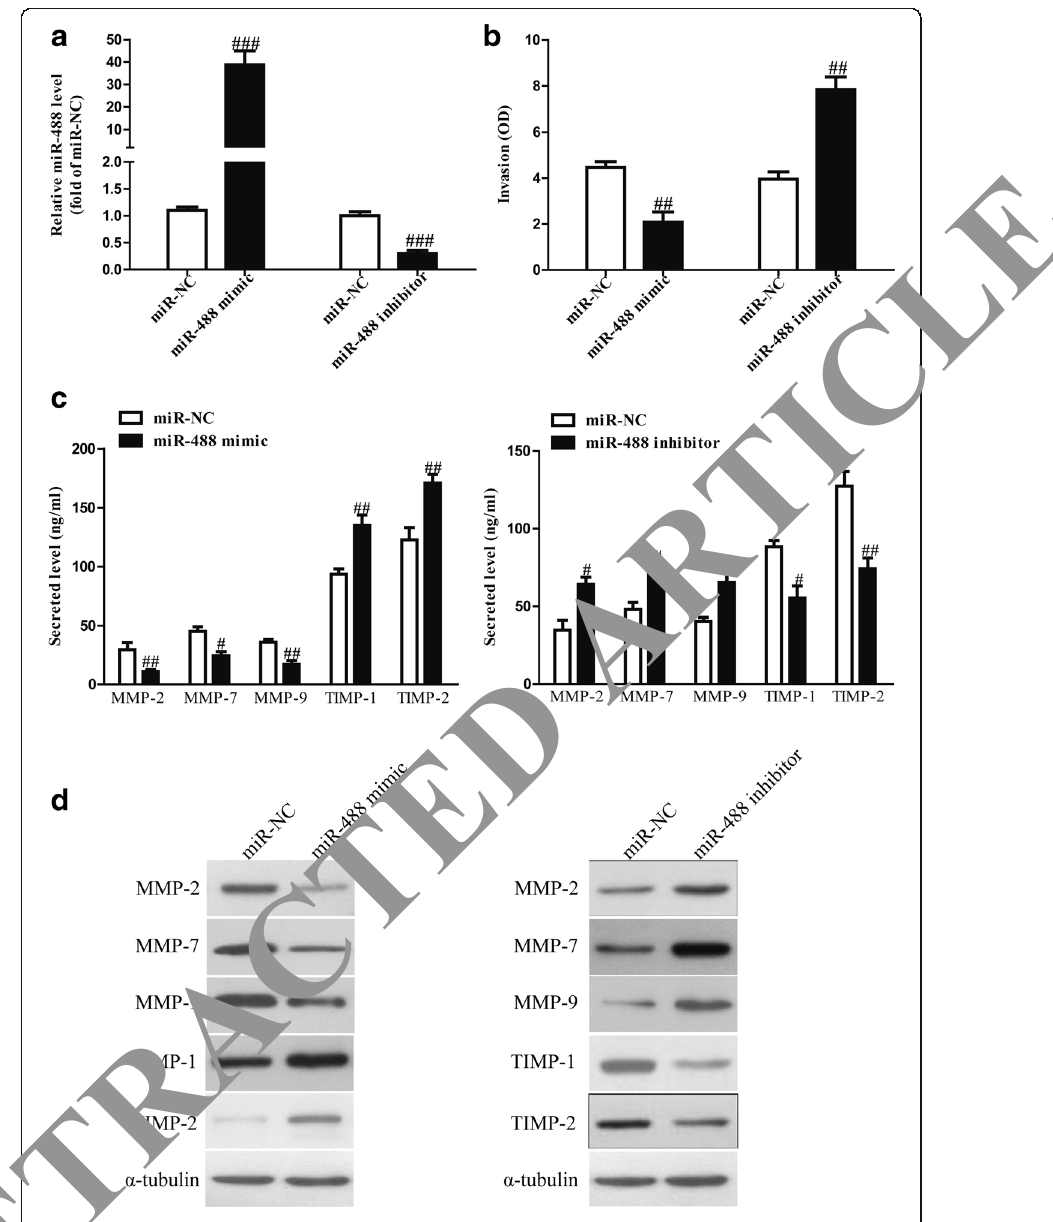
Fig. 4 The effects of miR-488 on invasion and related molecules in TSCC cells. TCA8113 cells were transfected with miR-488 mimic or inhibitor for 48 h. a Invasion was assessed using a transwell assay. b The protein expressions of MMP-2, MMP-7, MMP-9, TIMP-1 and TIMP-2 were determined using western blot and ELISA assays. All data are presented as means ± SEM, n = 6. # p < 0.05, ## p < 0.01, ### p < 0.001 vs.